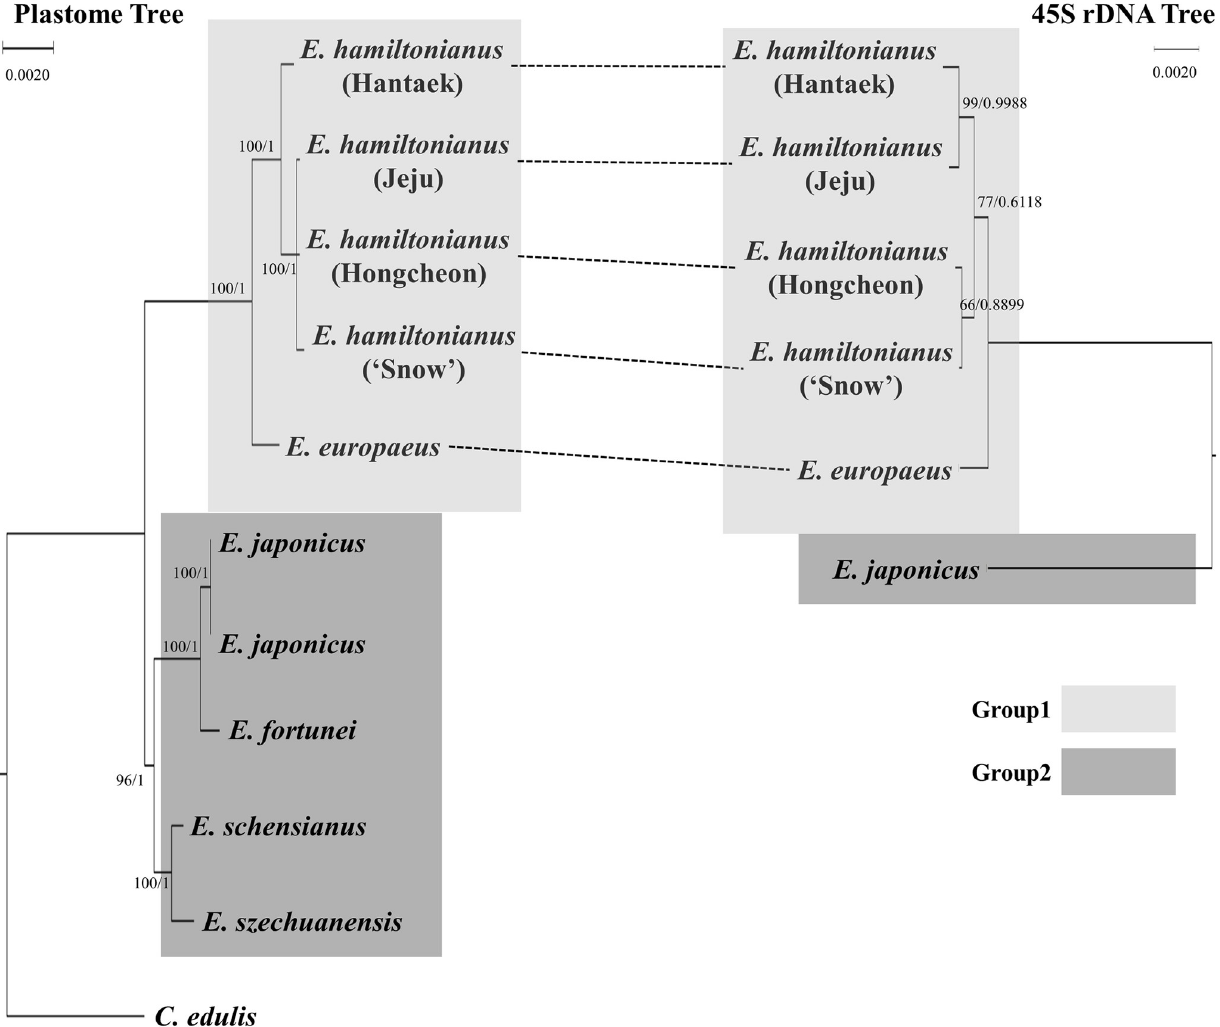
Fig 5. Phylogenetic tree of the ten Euonymus accessions based on plastome and 45S rDNA sequences. The tree on the left was drawn using common plastome coding sequences, and the tree on the right was drawn using common 45S rDNA sequences. The phylogenetic trees were constructed using the Bayesian Inference method. Bootstrap (ML method) and posterior probability values greater than 50% were shown. The supporting values separated by slash are bootstrap values and posterior probability, respectively.